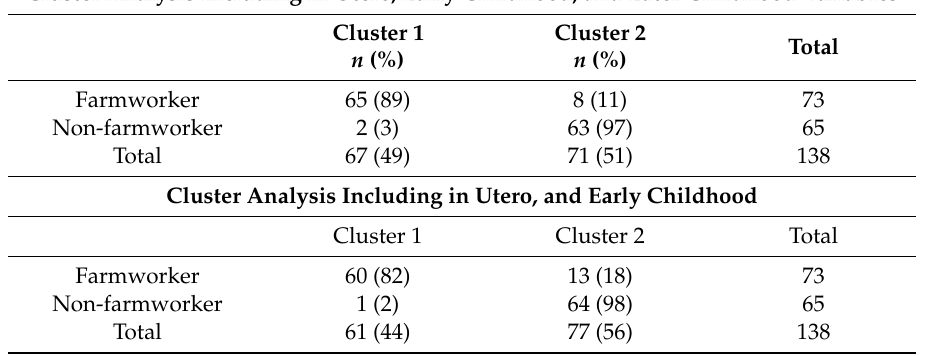
Table 4. Results of cluster analyses using two variables (months living adjacent to fields and person-months household residents worked in toxic jobs) for three time periods (in utero and early childhood, later childhood) and two time periods (in utero and early childhood), comparing farmworker ( n = 73) and non-farmworker ( n = 65) samples. Counts and